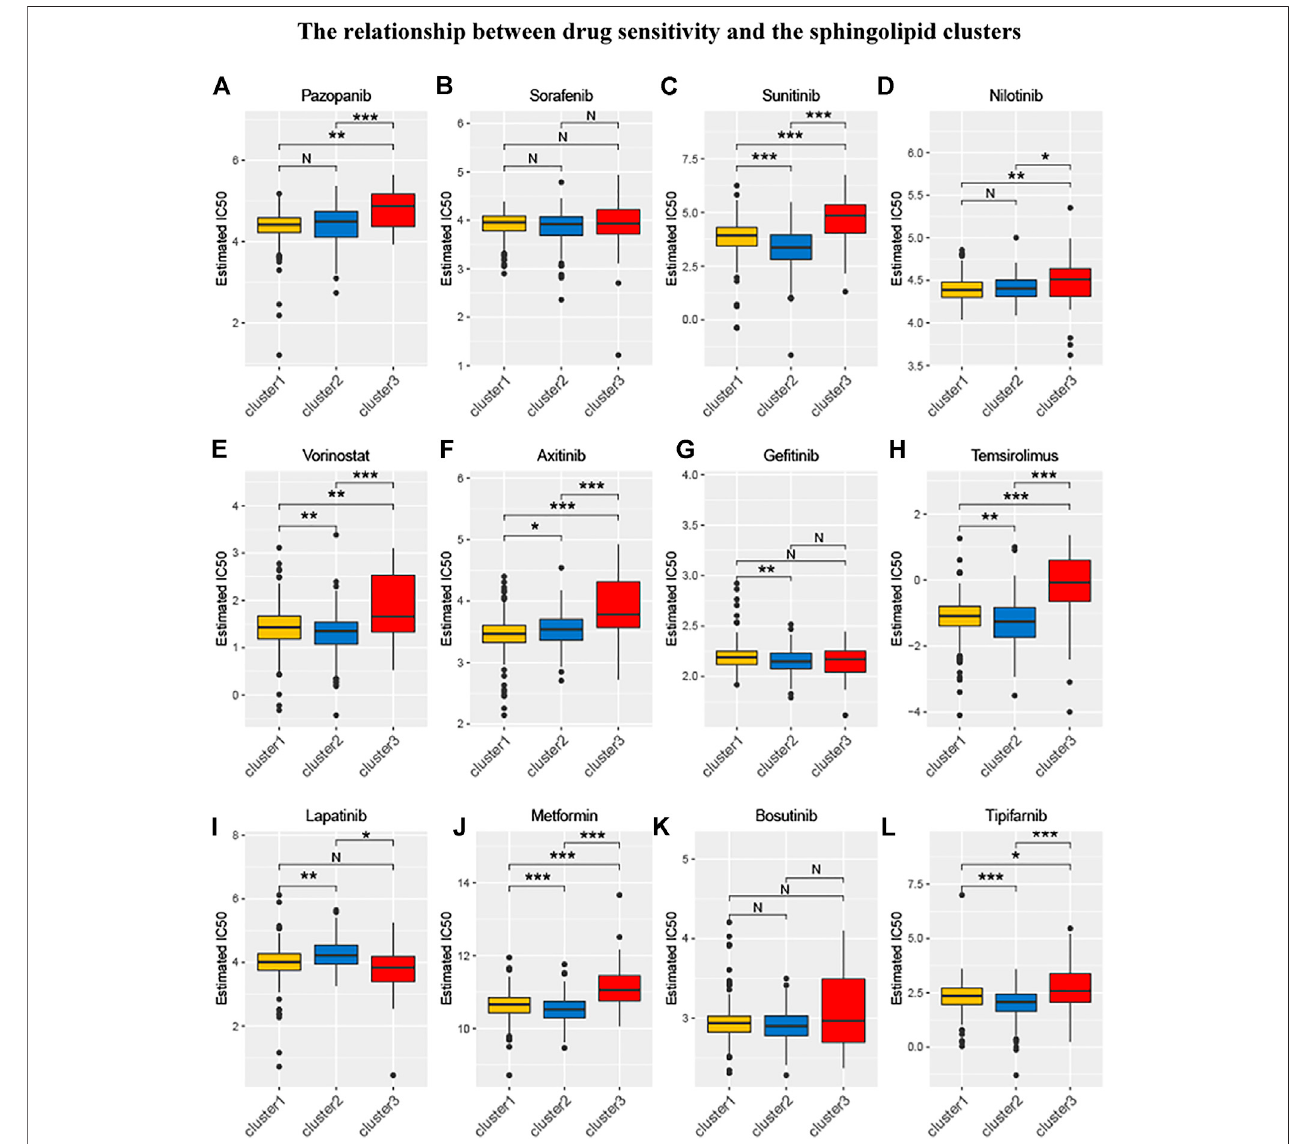
FIGURE7| Therelationshipbetweendrugsensitivityandthesphingolipidclusters.Theboxplotsoftheestimated IC50for12drugsareshown in (A – L) forCluster 1 (yellow), Cluster 2 (blue), and Cluster 3 (red). The 12 types of chemotherapeutic agents are pazopanib, sorafenib, sunitinib, nilotinib, vorinostat, axitinib, ge fi tinib, temsirolimus,lapatinib,metformin,bosutinib,andtipifarnib.Theasteriskaboverepresentsthe p- value; p < 0.05wasconsideredstatisticallysigni fi cant(N:0.05 < p *:0.01 < p < 0.05, **:0.001 < p < 0.01, and ***: p < 0.001). The box plots indicate that drug sensitivities among the sphingolipid clusters were different.